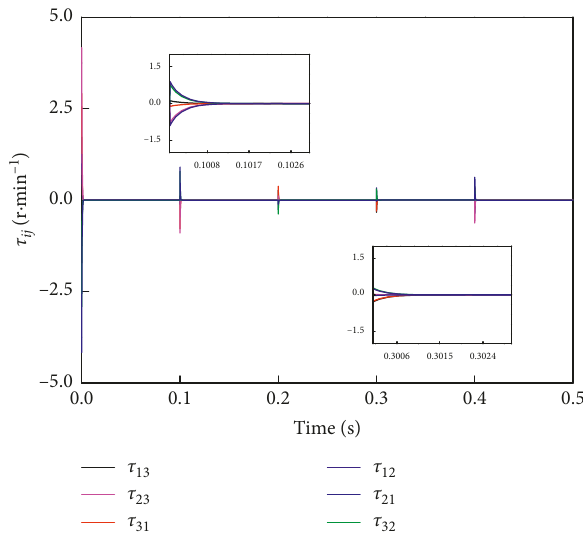
Figure 16: The synchronization error curves of all servos under multiple cycles.